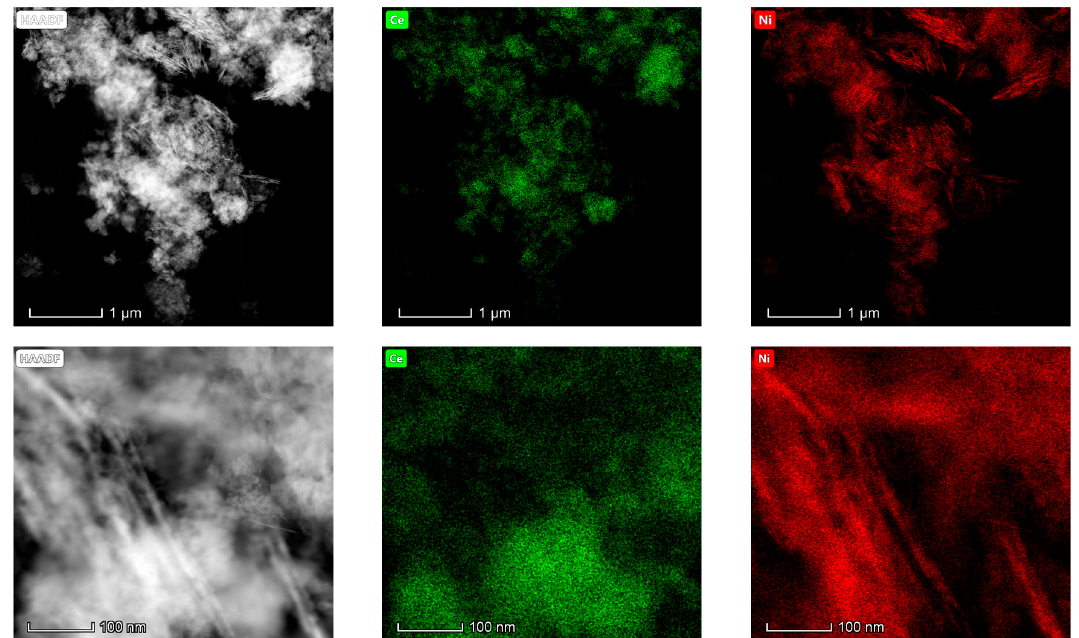
Figure 7. HAADF-STEM images of Ni-Ce-9 and EDS chemical maps of Ni and Ce.